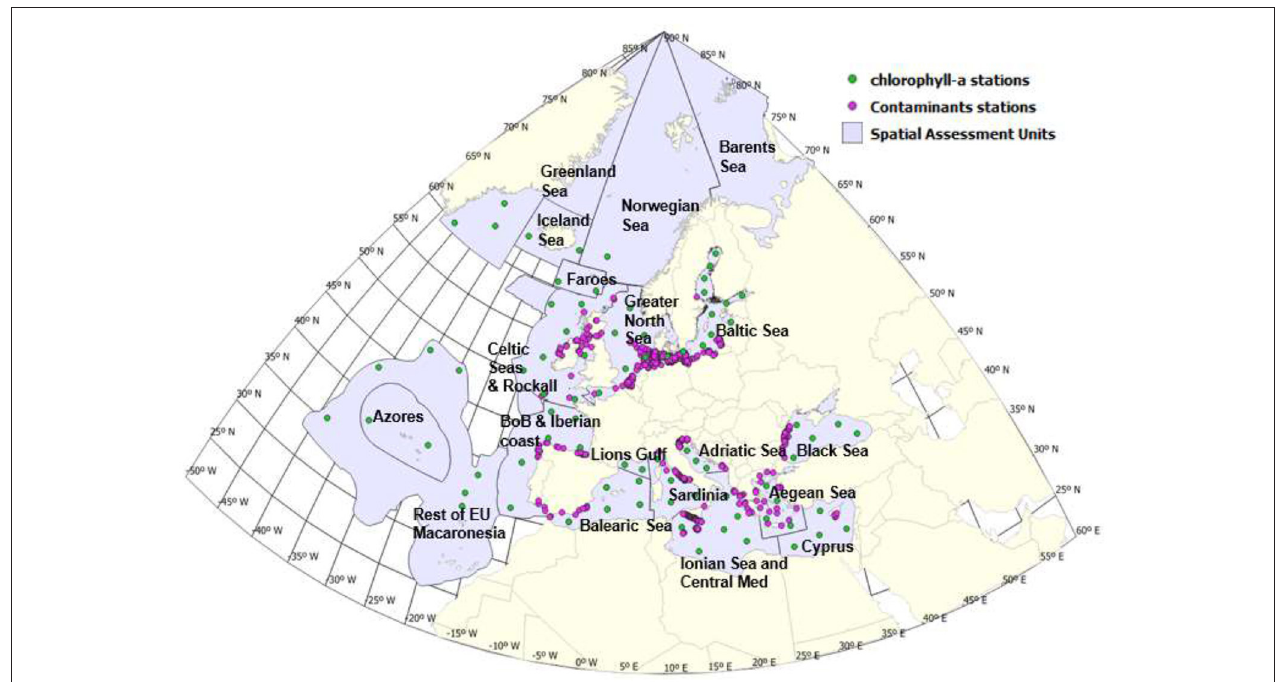
FIGURE 1 | Map of the European seas, showing the Spatial Assessment Units (SAUs) defined in this study, at different levels (subunits, subregions, regional seas). The sampling stations for contaminants (pink points) and chlorophyll a (green points) are shown. BoB, Bay of Biscay; EU, European Union.